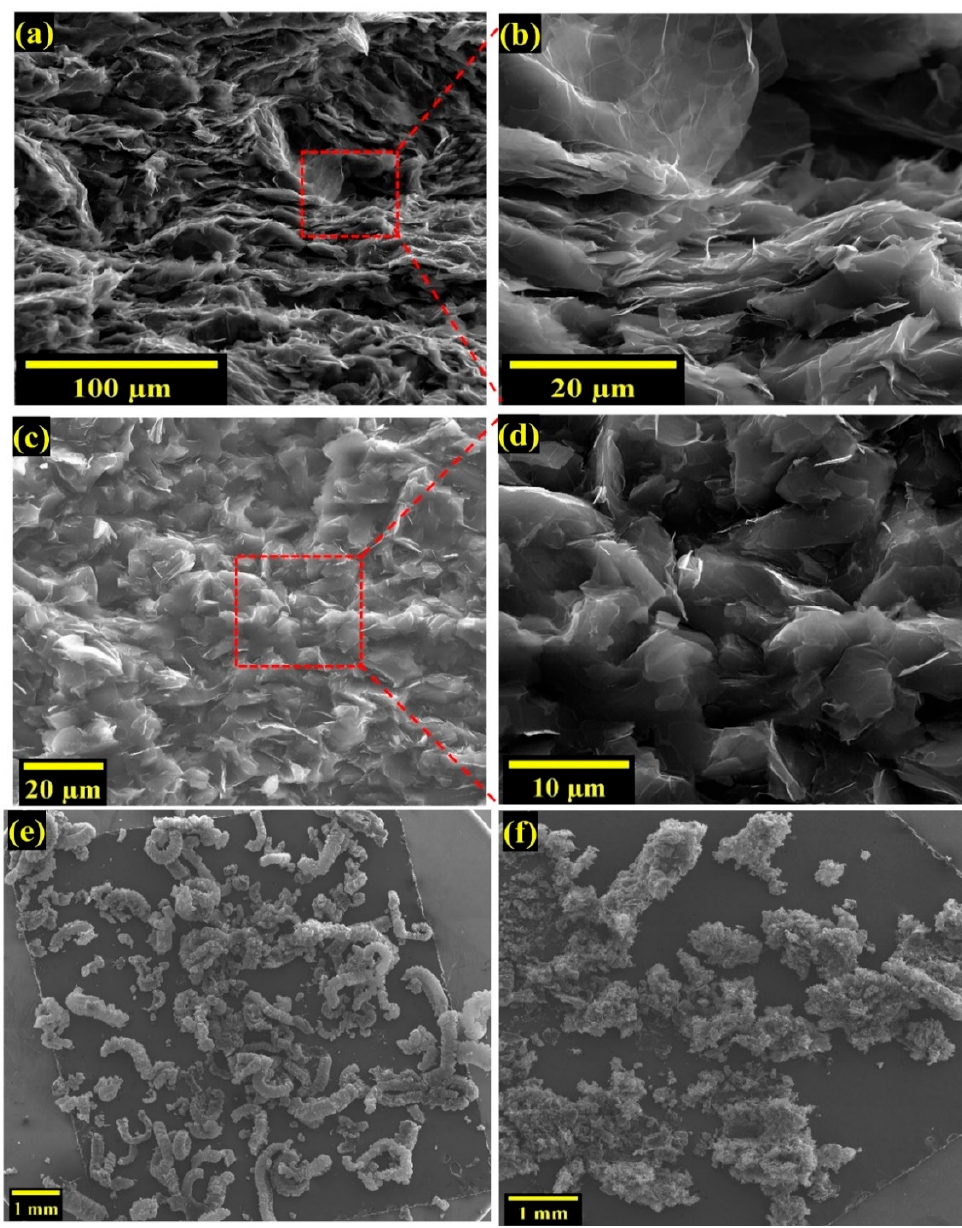
Figure 5. FE − ESEM images of ( a , b ) 10 wt% EG/PEID composite with ultrasonication for 3 min at 20% amplitude, ( c , d ) 10 wt% GnP/PEID composite with ultrasonication for 40 s at 20% amplitude; FE − ESEM images of EG at 20% sonication for ( e ) 40 s and ( f ) 3 min using montage large area mapping.